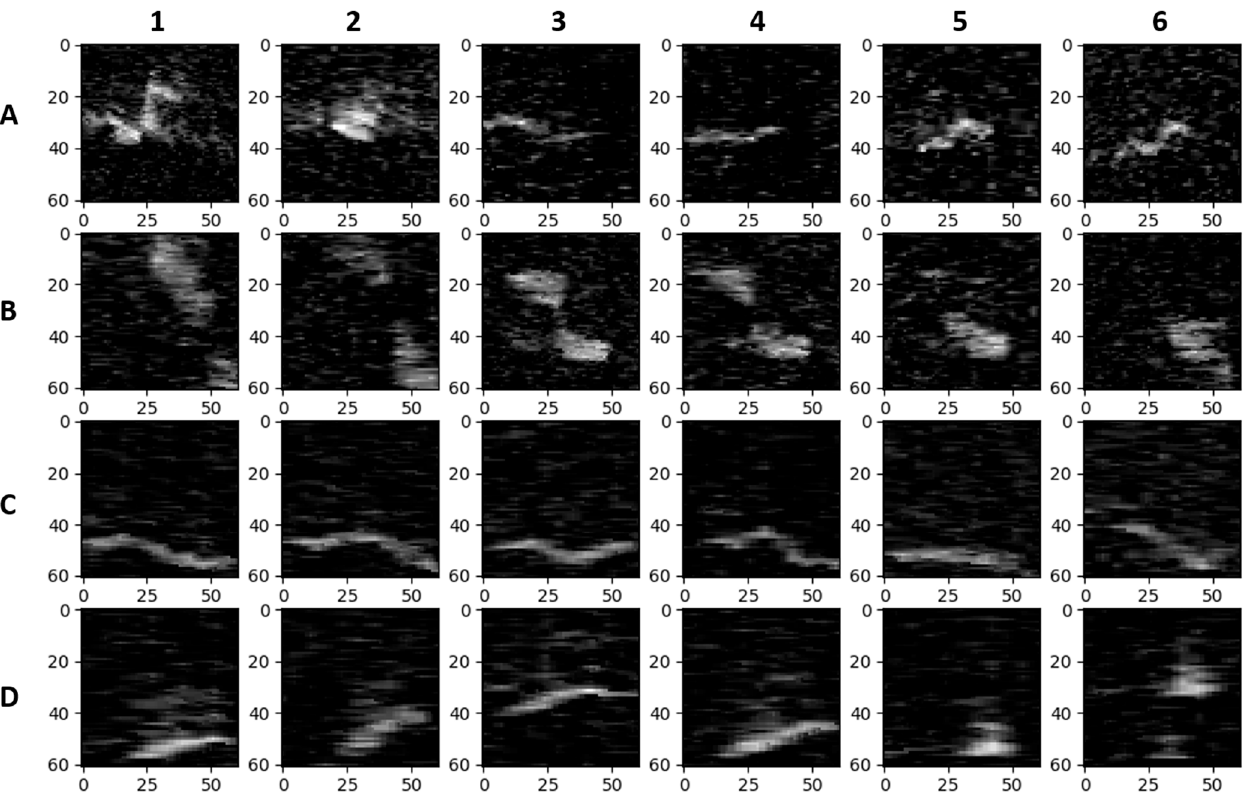
Figure 3. Example images (61 × 61 pixels) of eels and sticks after background removal: eels in the field (Row A ), sticks in the field (Row B ), eels in the laboratory (Row C ), and sticks in the laboratory (Row D ). Column 1 and 2 are the same target at different times, the same for columns 3 and 4 as well as columns 5 and 6.